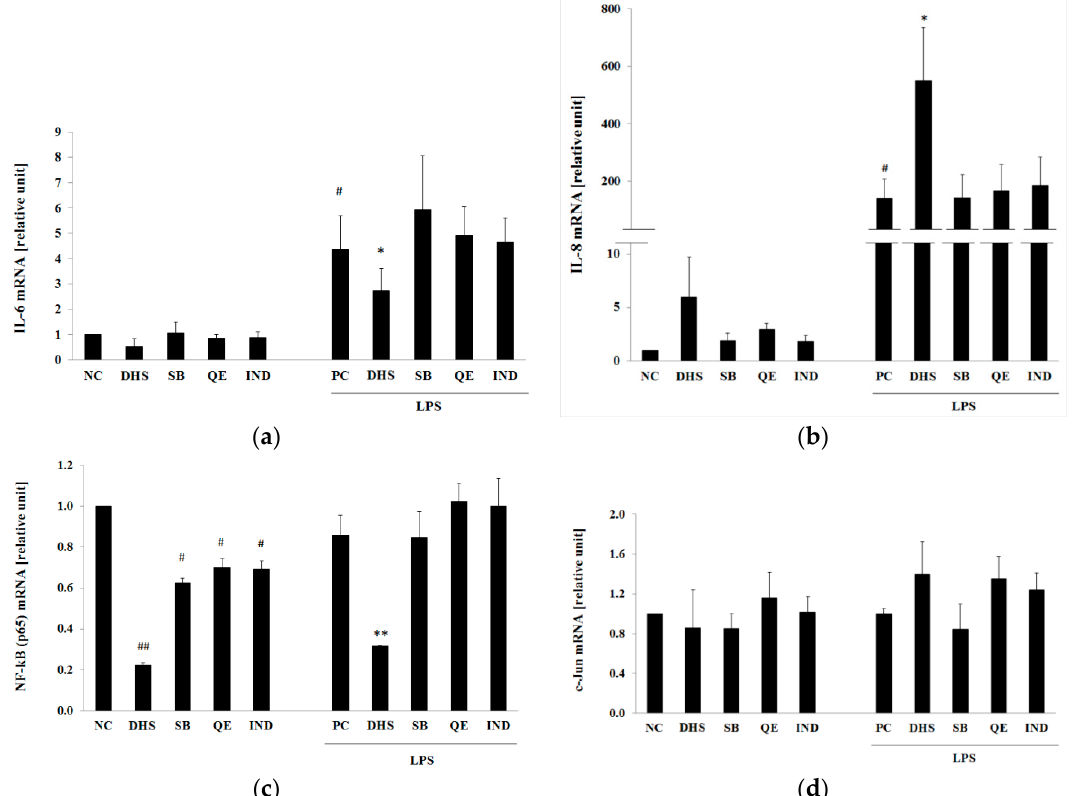
Figure 4. Effects of the selected silymarin components and IND on IL ‐ 6 ( a ); IL ‐ 8 ( b ); NF ‐κ B (p65) ( c ) and AP ‐ 1 (c ‐ Jun) ( d ) mRNA levels with or without the previous LPS challenge. The gene expression analysis was conducted using RT ‐ PCR at 24 h after exposure to 10 μ M DHS, SB, QE or IND with or without previous 6 h LPS challenge. RPL13A was used as an internal standard. Data are presented in arbitrary units as mean relative to NC ± SEM ( n = 5), significantly different from NC ( # p < 0.05; ## p < 0.01) or PC (* p < 0.05; ** p < 0.01). NC: negative control (0.1% vehicle DMSO in serum-free culture medium), PC: positive control (6 h of LPS stimulation followed by 24 h incubation with 0.1% vehicle DMSO in serum-free culture